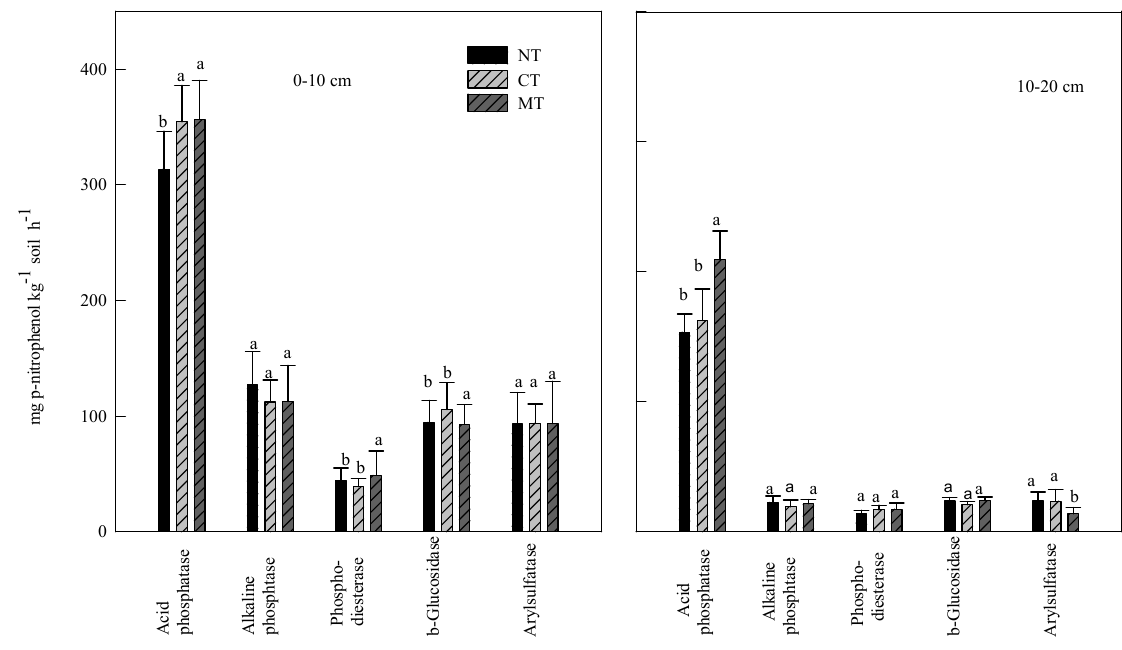
Figure 1. Effect of tillage systems on phosphatase, β -glucosidase, and arylsufatase at two different soil depths. Different letters indicate significant differences between tillage for each enzyme